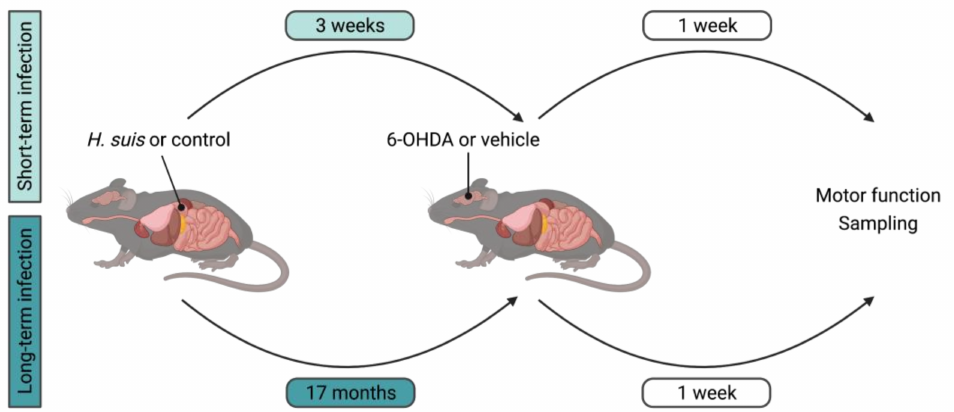
Figure 1. Experimental set-up to investigate the effect of Helicobacter suis ( H. suis ) infection in a 6-hydroxydopamine (6-OHDA) mouse model of Parkinson’s disease (PD). Animal experiments were carried out consisting of a short- and long-term infection group, respectively. C57BL/6OlaHsd mice were intragastrically inoculated at the age of 42 days with 300 µ L of a stock solution containing 1 × 10 8 viable H. suis HS1 bacteria/mL (n = 10 for short-term and n = 11 for long-term) or with the growth medium of the bacteria (i.e., Brucella broth (pH 5)) as negative controls (n = 10 for short- term and n = 9 for long-term). Twenty-one days post-infection (short-term group) and 500 days post-infection (long-term group), mice were injected in the left striatum with either 1 µ L of 6-OHDA hydrochloride solution (16 µ g/ µ L 6-OHDA in 0.2% ascorbic acid) or the vehicle solution (0.2% ascorbic acid in phosphate buffered saline). Seven days after intrastriatal injection, mice were sampled. Behavior and motor function tests were performed at two different timepoints. Baseline testing took place in the week before intrastriatal injection. The second testing took place 5–6 days after intrastriatal injection and 1–2 days prior to